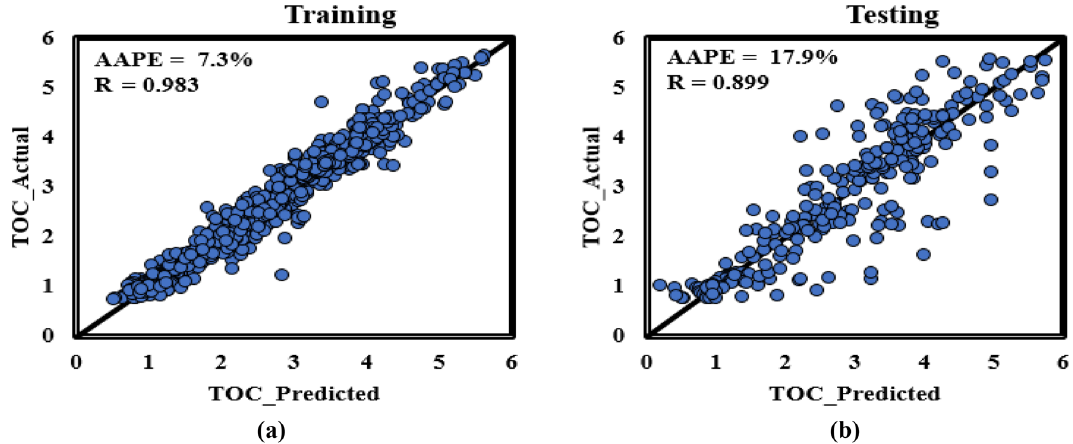
Fig. 8 Cross-plots of the ANFIS-predicted and measured TOC for a the training and b the testing datasets